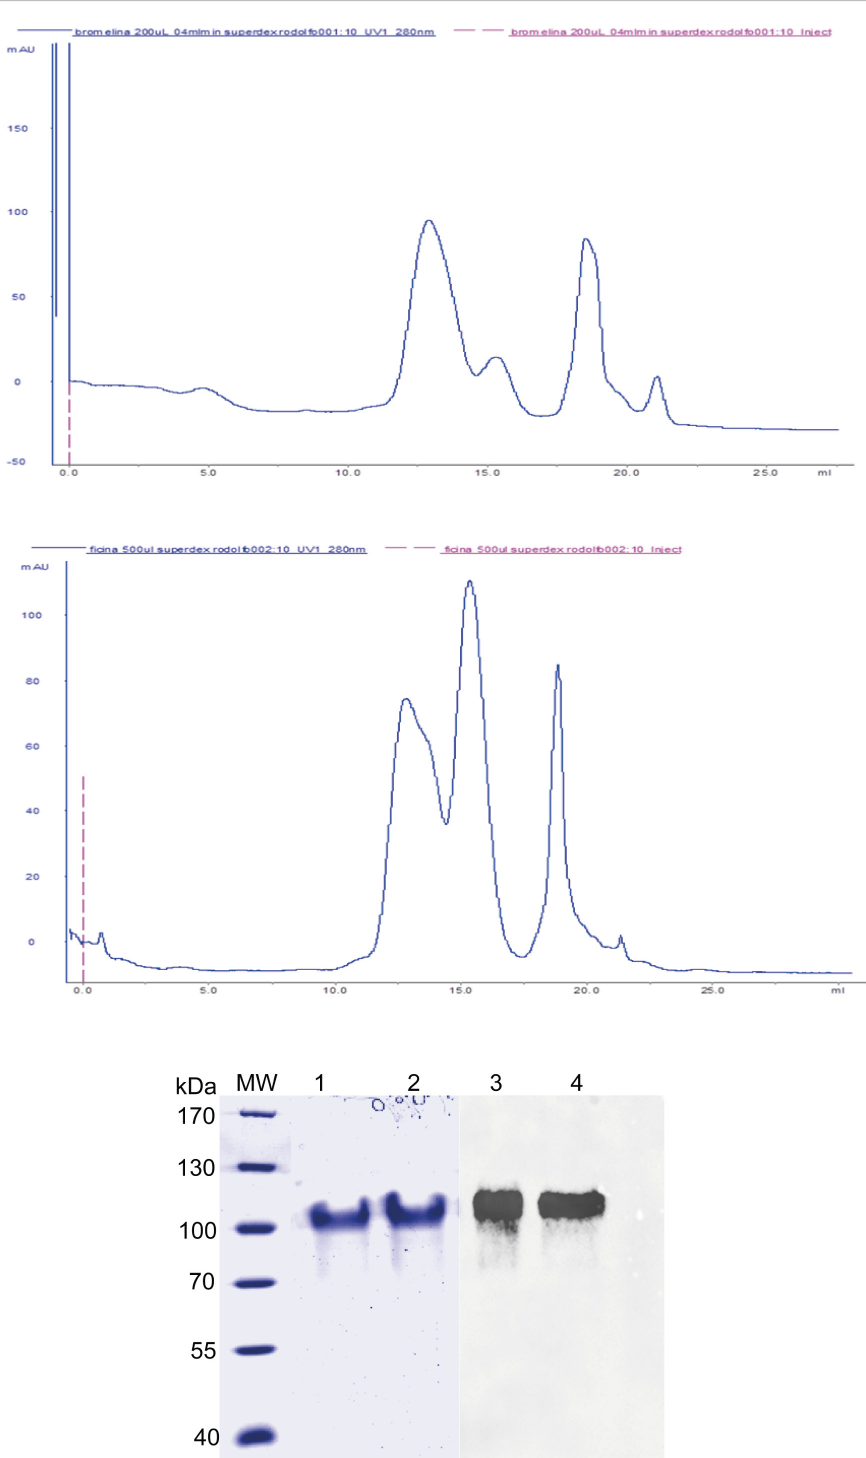
FIGURE 3 - Purification of anti-bothropic serum fragments by gel filtration chromatography and analysis of immunoreactivity by western blotting. (A) Bromelain and (B) Ficin FPLC gel filtration chromatography werre performed according to “Materials and Methods”, under a constant flow of ammonium bicarbonate 50 mM and monitored at 280 nm. Fractions were collected manually for SDS-PAGE analyses. (C) 10 % SDS-PAGE analysis under reducing conditions (on left side) of purified F(ab)’ fragments, gel stained with Coomassie blue, was performed applying 2 µg of protein per lane and Western blotting analysis was performed using the same fractions and concentration (on the right side). Bromelain and ficin generated F(ab)’ represented in line 1 and line 2,